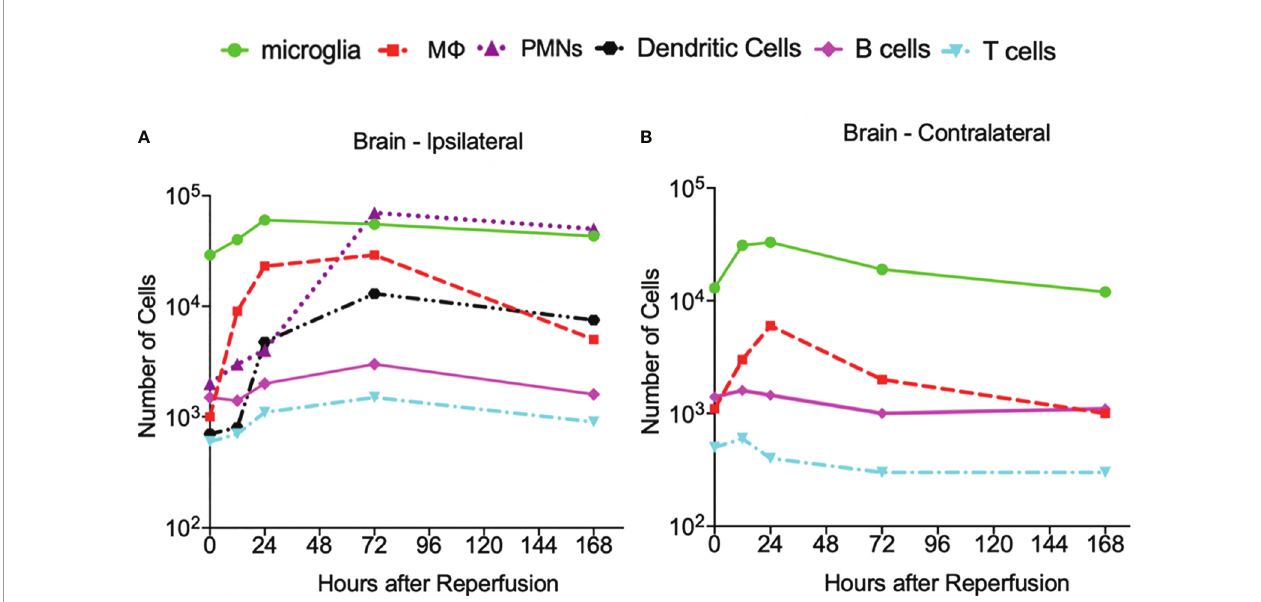
FIGURE 6 | The dynamics of the cell count as a function of hours after insult obtained from the data presented in reference (2). (A) At the ipsilateral hemisphere of the brain. (B) At the contralateral hemisphere of the brain. A log scale is used to illustrate the vastly different number of cells on the same axes. N=3-4 mice were used for each time point and the experimented were replicated 3